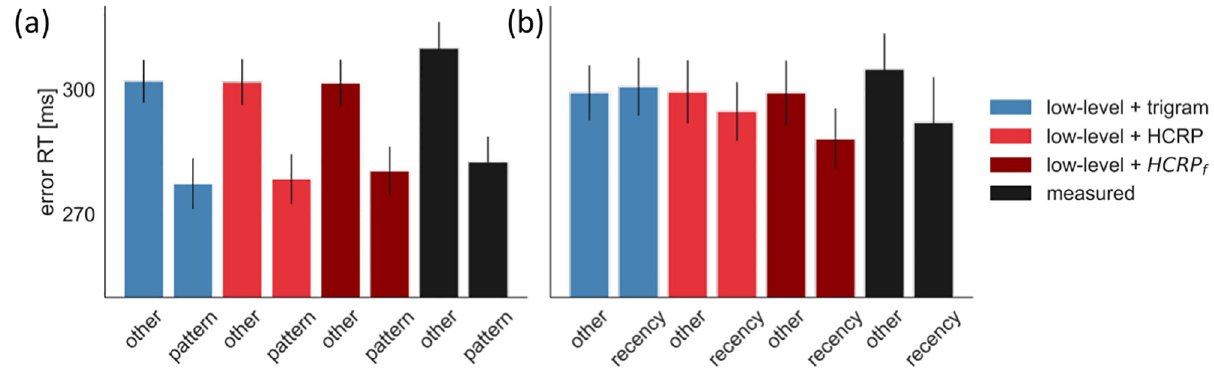
Fig 9. Predicting the latency of errors. (a) Pattern errors. (b) Recency errors. In the case of HCRP f , the hyperparameter priors were adjusted to express more forgetfulness. The error bars represent the 95%CI.